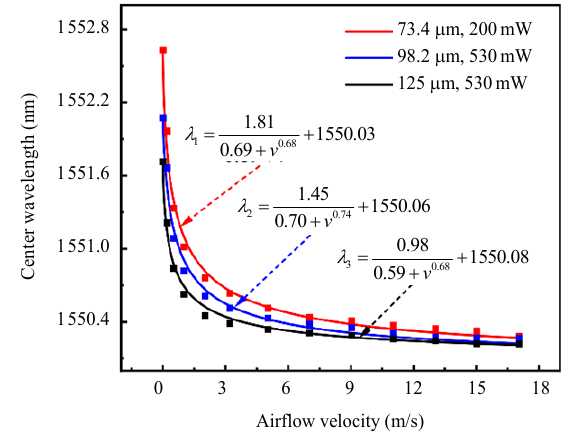
Fig. 5 Measured center wavelength versus applied airflow velocity for the three FBG anemometer